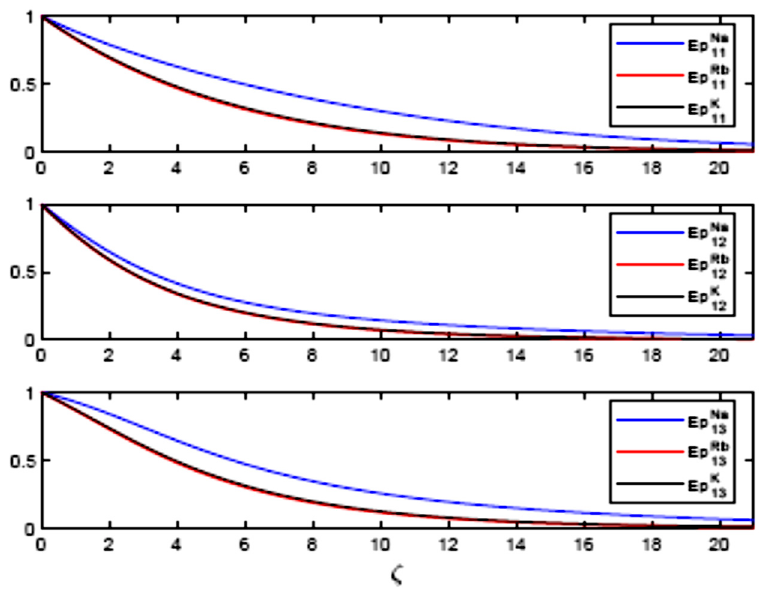
Figure 3. Attenuation of the relative energies for probe pulses in different alkali vapours. Energies E 11 , E 12 , and E 13 for probe and drive fields to correspond to time sections τ = [0, 85], τ = [85, 170], and τ = [170, 250], respectively.